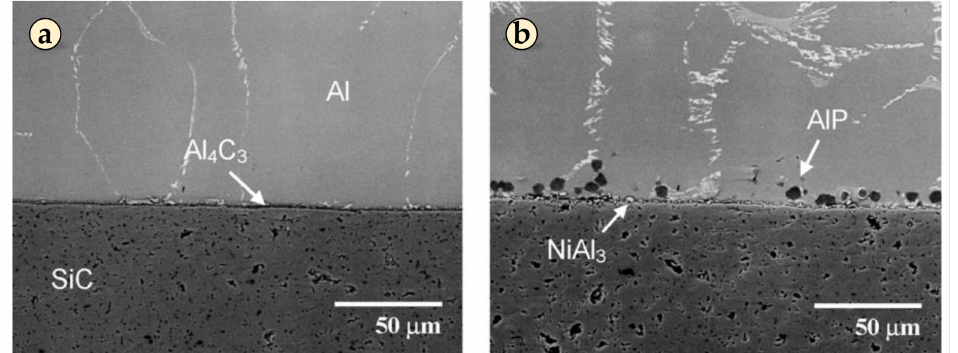
Figure 11. Wettability of aluminum with ( a ) bare SiC, and ( b ) Ni-coated SiC, at 800 ◦ C reproduced from [22] with permission of